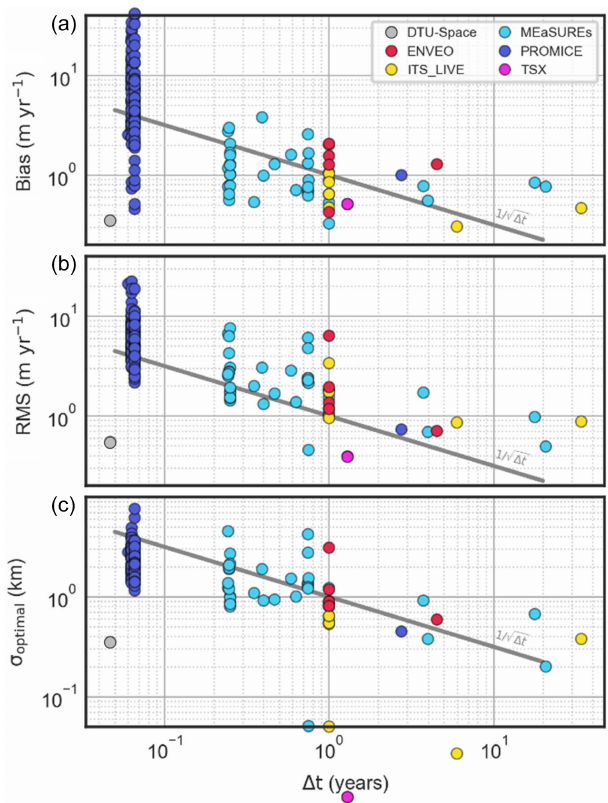
Figure 6. Results of the assessment of a list of 165 satellite-derived surface velocity products: (a) the mean bias in the velocity product compared to the GPS-derived velocities at the location of the GPS poles, (b) the standard deviation of the velocity products relative to GPS-derived velocities (RMS), and (c) the optimal smoothing length of the velocity product that minimizes the standard devia- tion ( σ ). All results are shown as a function of (cid:49)t , the time span of the velocity product. Notice that some products have been av- eraged over time to provide results with longer temporal coverage. The gray lines suggest a linear dependency of the bias, RMS, and σ on the inverse of the square of the temporal coverage (cid:49)t .